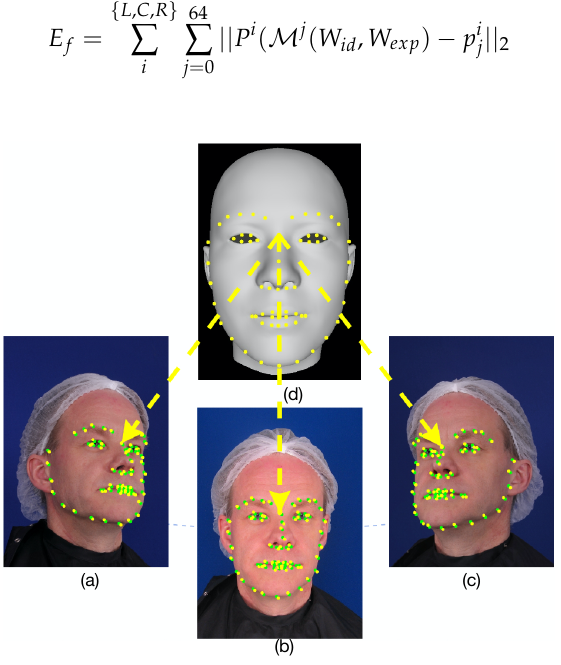
Figure 3. The schematic diagram of the feature prior constraint. In each viewpoint image, the projection of landmarks (yellow pixels in ( a – c )) should have the same coordinate as the extracted feature pixels (green